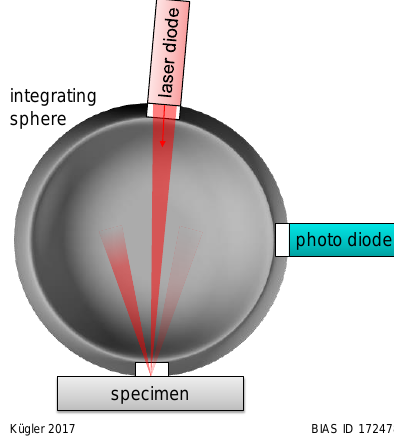
Figure 2. The principal of the measurement system for detecting the reflection share for calculation of the absorptivity of irradiated specimens.